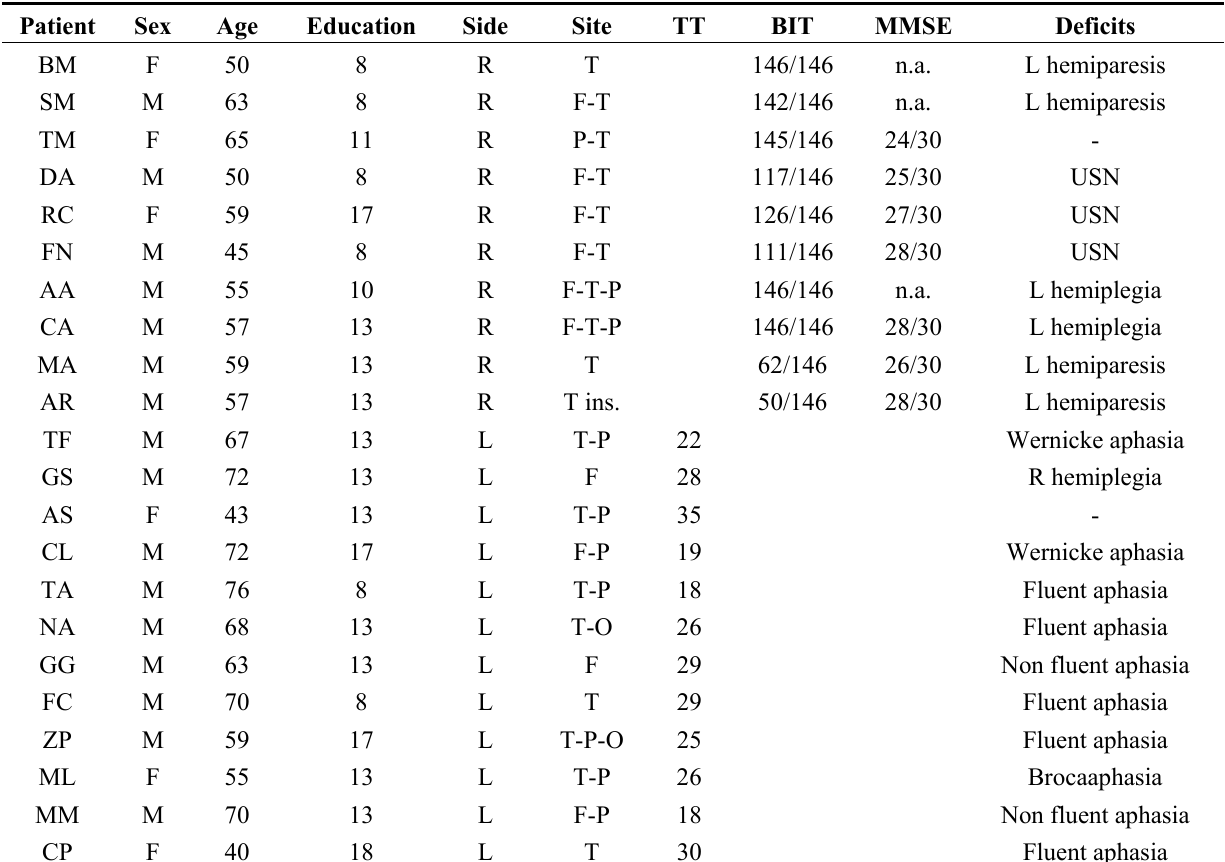
Table 2. Demographical and clinical data of the 10 RBD and the 12 LBD included in the study. Legend: R = right; L = left; F = frontal, T = temporal, P = parietal, ins = insula; n.a. = not assessed, USN = unilateral spatial neglect. TT cut-off > 29; conventional BIT cut-off < 129; MMSE ≥ 26.